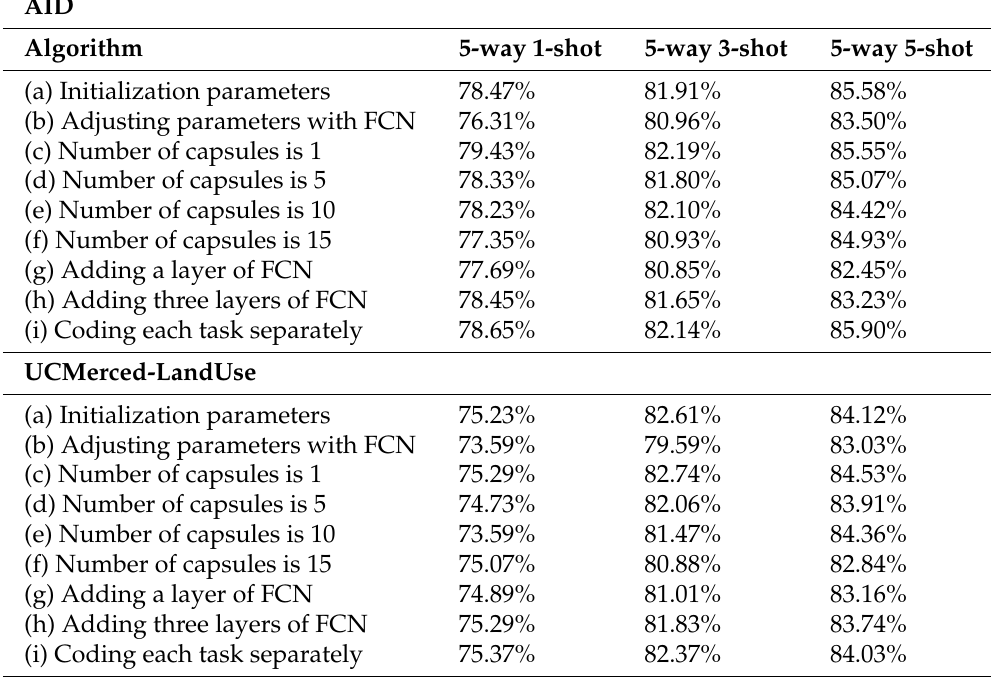
Table 2. Comparison of classification accuracy (accuracy ± 95%) between different settings of task-covariant meta-learning algorithm and other similar works on the AID and UCMerced- LandUse